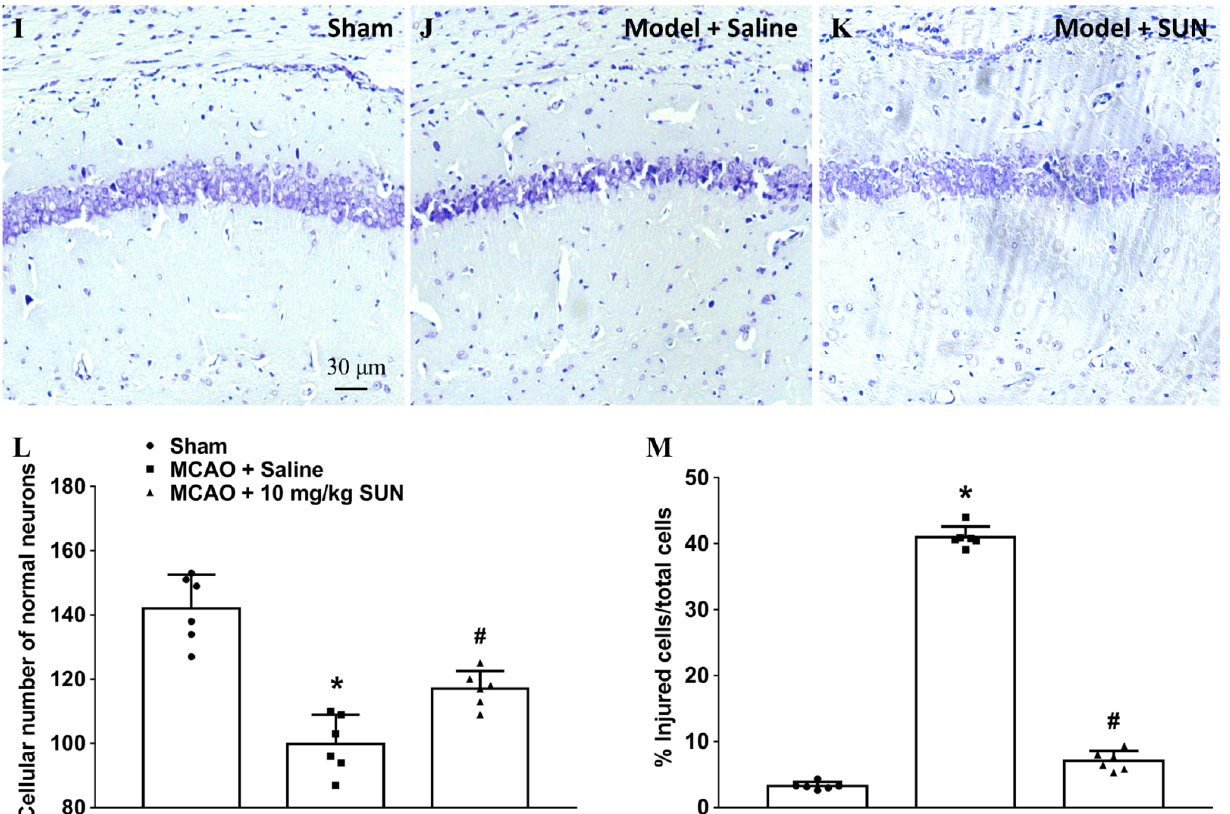
Figure 4. Effect of DAAO inhibitor SUN in preventing delayed hippocampal neuronal death after MCAO surgery. ( A – D ) Immunostaining colocalization of hippocampal GFAP/DAAO was performed on day 5 in MCAO mice. ( E – H ) Hippocampal immunofluorescence NEUN and TUNEL staining were executed on day 5 in MCAO mice. The red rectangle represents the hippocampal CA2 region. ( I – M ) Numbers of normal neurons and injured cells were identified by Nissl staining in hippocampal CA2 area on day 5 after ischemic strokes. Hippocampal neurons containing Nissl bodies were recorded as normal cells. Pyknotic nuclei with condensed chromatin were defined as injured cells. Data are expressed as means ± SEM ( n = 6). * denotes statistical significance ( p < 0.05) compared with sham group; # denotes significant difference from the model group treated with saline ( p < 0.05) calculated by unpaired two-tailed Student’s t